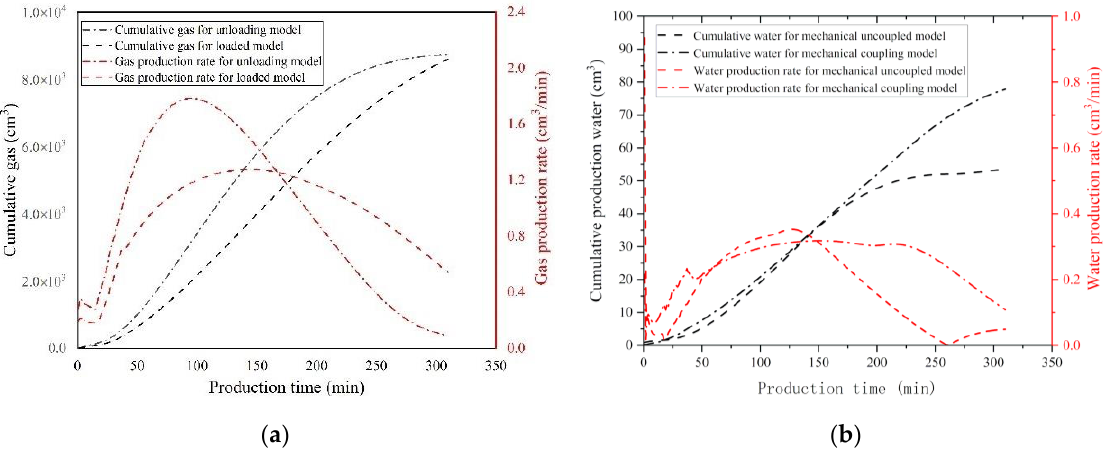
Figure 5. ( a ) Gas and ( b ) water production characteristics for the mechanical uncoupled and coupled model.